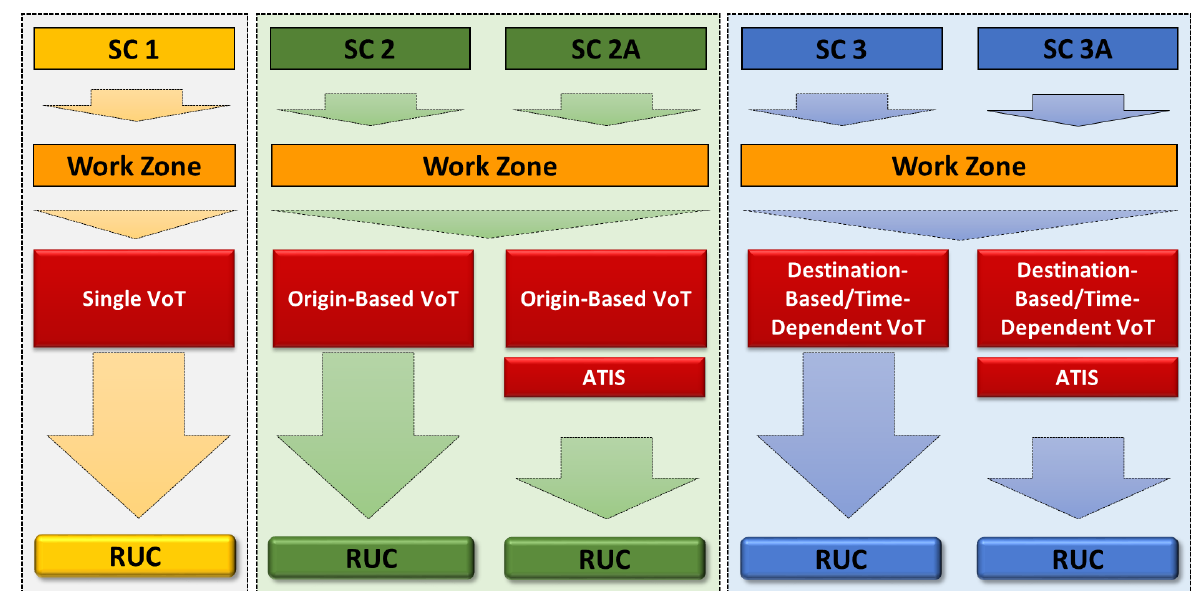
Figure 8: Scenario analysis—methodology flow chart